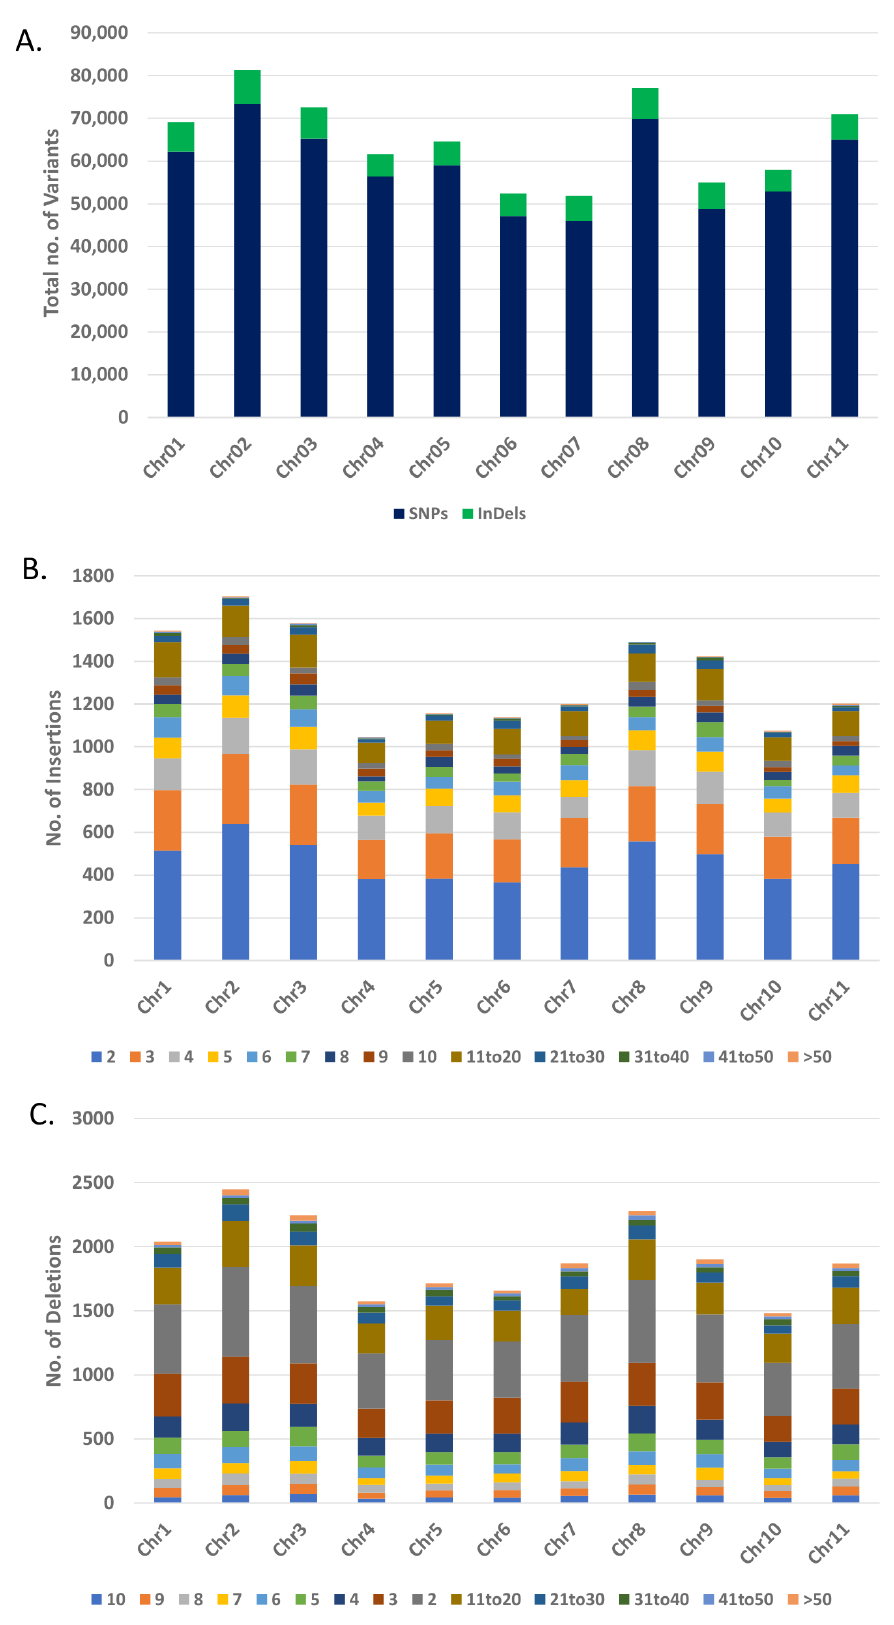
Figure 5. Genome-wide distribution of SNPs and InDels. Chromosome-wise distribution of SNPs and InDels ( A ). Chromosome-wise distribution of indels ranging from 2 bp to >50 bp ( B ). Chromosome-wise distribution of indels ranging from 2 bp to >50 bp ( C ).